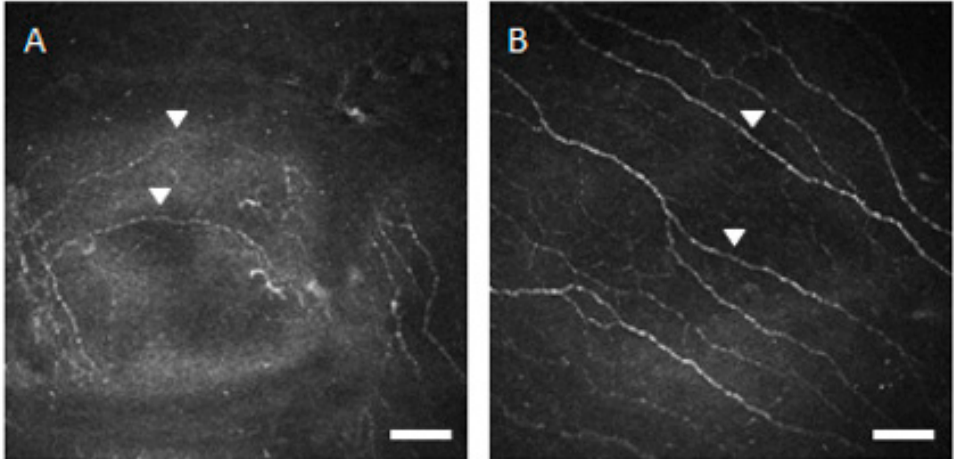
Figure 3. Representative in vivo confocal microscopic corneal sub-basal nerve images. ( A ) Image from patient with Sjögren’s syndrome shows very tortuous sub-basal nerve fibers classified in grade 4 (arrowheads). Bar = 50 µ m. ( B ) Image from healthy control subject shows slightly tortuous sub-basal (arrowheads). Bar = 50 μ m. ( B ) Image from healthy control subject shows slightly tortuous sub-basal nerve fibers classified in grade 1 (arrowheads). Bar = 50 µ nerve fibers classified in grade 1 (arrowheads). Bar = 50 μ m.